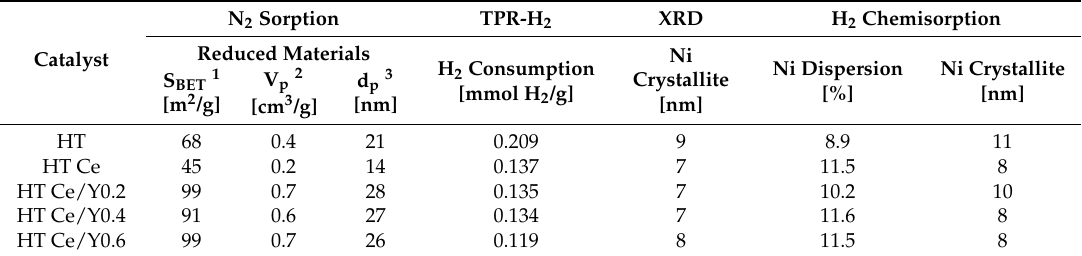
Table 2. Texture, reducibility and Ni dispersion and Ni crystallite sizes for the studied materials after reduction in a mixture of 5 vol.% H 2 /Ar.